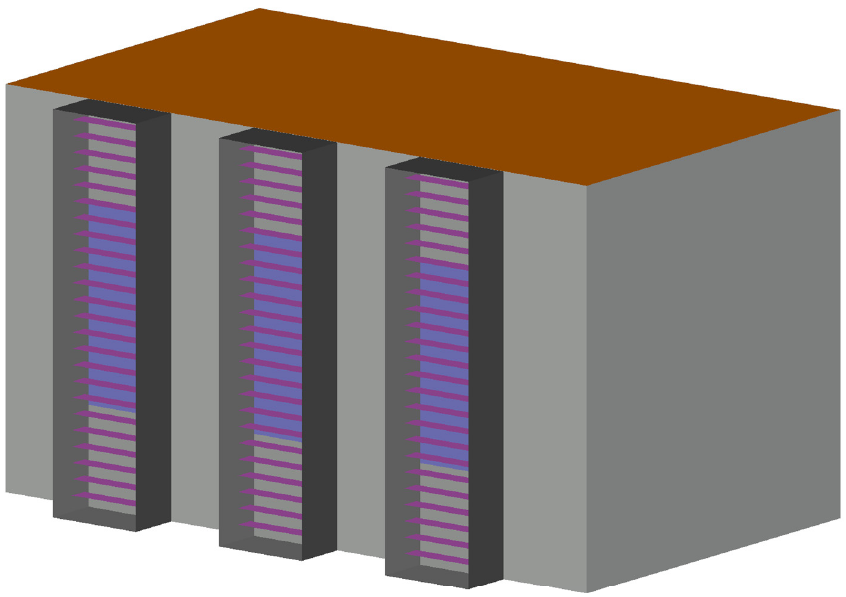
Figure 2. Scheme of the virtual chamber equipped with three DSF.